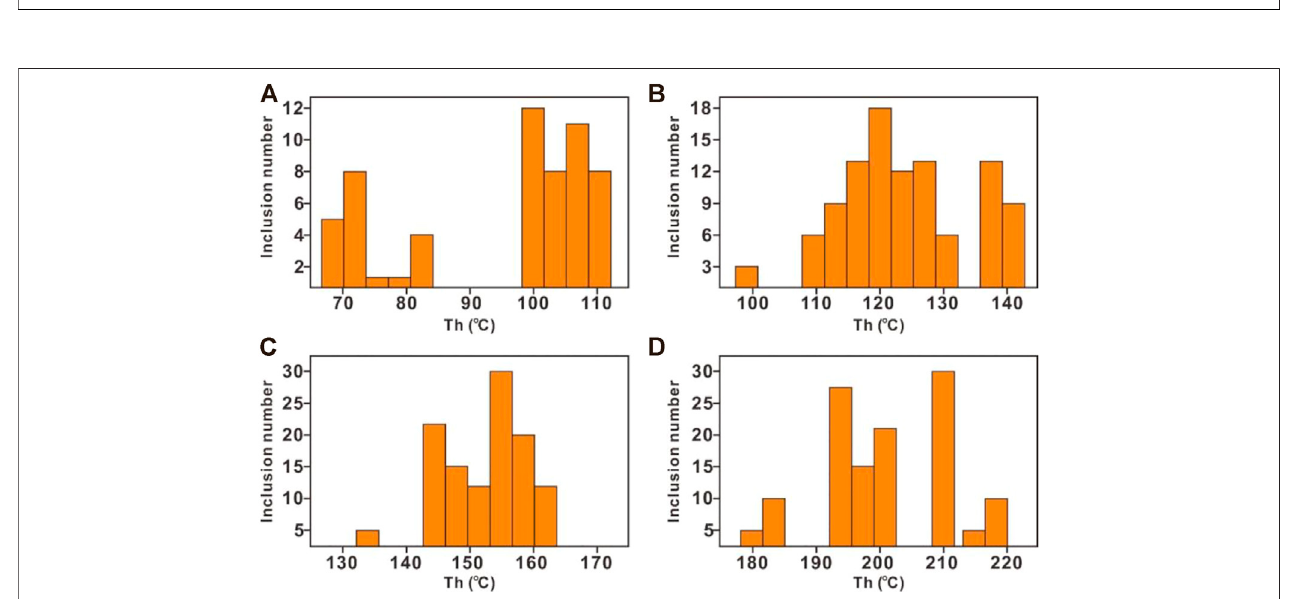
FIGURE 7 | Histograms showing homogenization temperatures of different types of dolomites. (A) Micritic dolomite matrix. (B) Fine-to medium-sized dolomites. (C) Medium-to coarse-sized dolomites. (D) Dolomite cements.